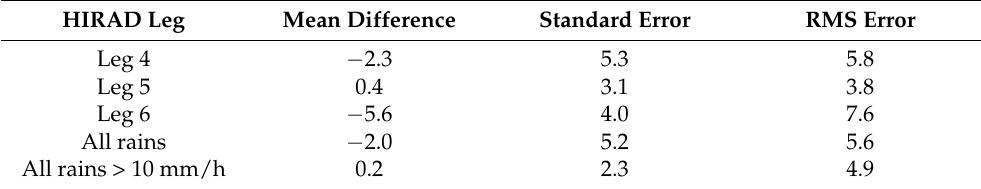
Table 3. HIRAD difference statistics with HIWRAP (HIWRAP-HIRAD)